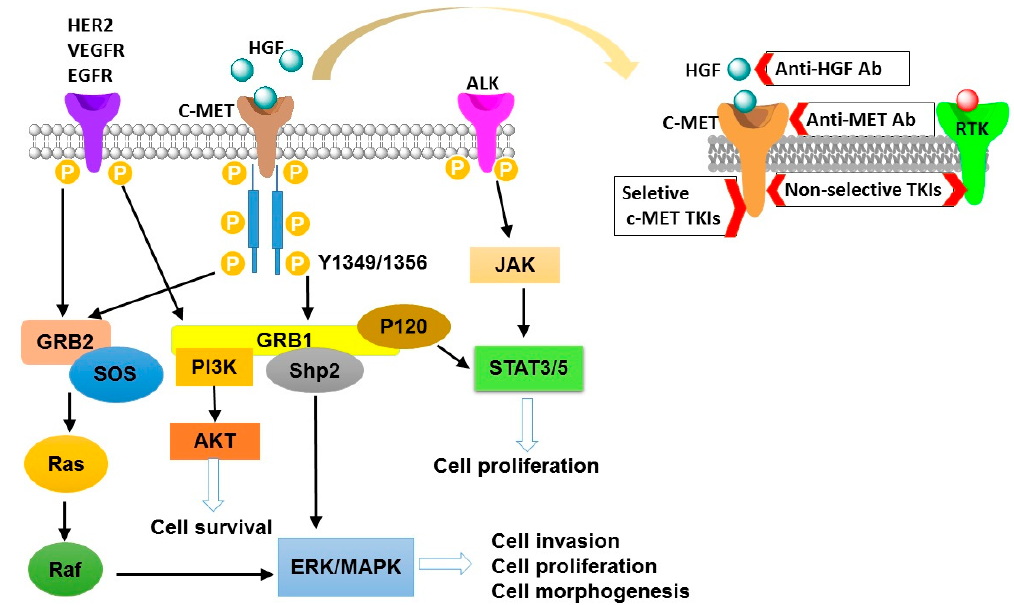
Figure 1. The schematic diagram of c-mesenchymal–epithelial transition (c-MET) activation signaling pathways. Activated c-MET binds adaptor molecules GRB-1 and GRB-2, and then they recruit Ras/Raf, SH2 containing protein tyrosine phosphatase (Shp2), STAT3/5, and PI3K signals. In addition, activation of other receptor tyrosine kinases (RTKs) signaling molecules (HER2, VEGFR, EGFR, and ALK) may cross-talk with the c-MET, further recruiting PI3K, ERK, and STAT3/5 signals. These downstream signals are involved in regulating cell morphogenesis, survival, proliferation, and invasion. Inhibition of the HGF/c-MET pathway can be achieved through c-MET kinase inhibitors (TKIs), anti-HGF monoclonal antibodies (Anti-HGF Ab), and anti-MET monoclonal antibodies (Anti-MET Ab). HGF, hepatocyte growth factor; ALK, anaplastic lymphoma kinase; JAK, Janus kinase; STAT3/5, signal transducers and activators of transcription 3/signal transducers and activators of transcription 5; HER2, human epidermal growth factor receptor 2; VEGFR, vascular endothelial growth factor receptor 2; EGFR, epidermal growth factor receptor; P, phosphorylation; GRB, growth factor receptor-bound protein; SOS, son of sevenless; Ras, GTPases and key transducers of receptor tyrosine kinase; Raf, raf kinase, effector of Ras; PI3K, phosphatidylinositide 3-kinases; AKT, protein kinase B; ERK, extracellular regulated protein kinases; MAPK, mitogen-activated protein kinase. The HGF/c-MET receptor tyrosine kinase (RTK) pathway is quiescent in normal tissue, while it